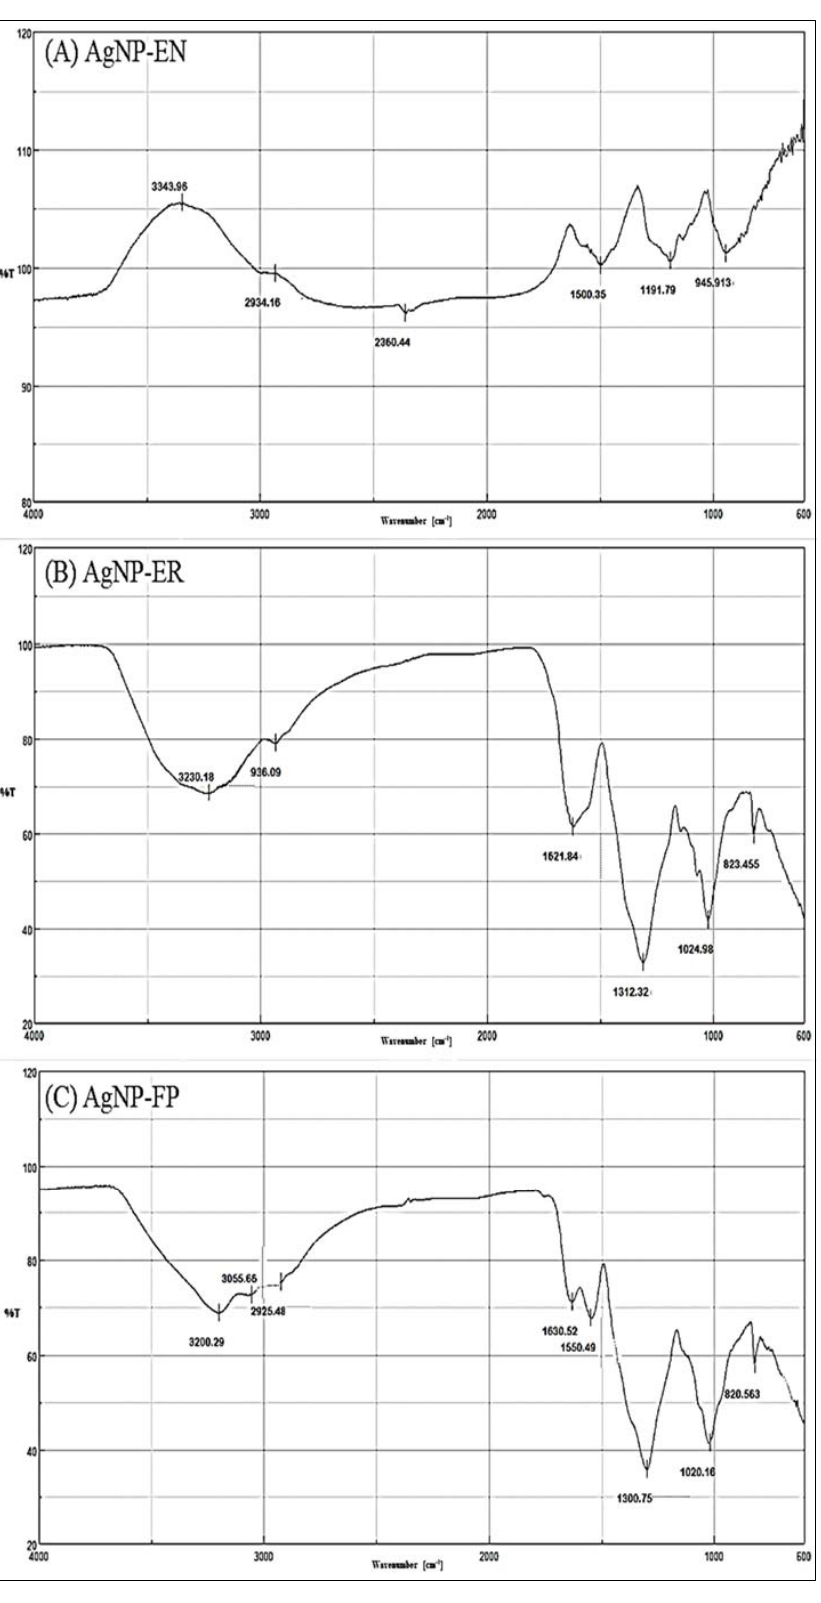
Figure 5. Fourier-transform infrared (FTIR) spectroscopy profile for the ( A ) AgNP-EN, ( B ) AgNP-ER, and ( C ) AgNP-FP.